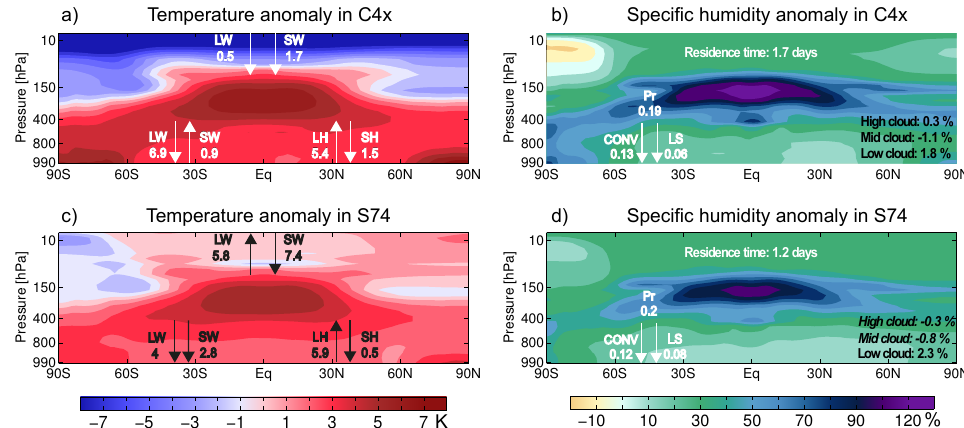
Fig. 4. Profiles of (a) the annual mean anomaly in temperature [K] and (b) the change in specific humidity [%] in the C4x scenario. (c, d) as in (a, b) but for the S74 scenario. The mean anomalies over the five ensemble members averaged over the years 71 to 100 of the corresponding scenario are indicated on the profiles. The energy fluxes are defined as positive in the direction of the corresponding arrow. The units of the energy flux anomalies in (a) and (c) are in Wm − 2 and the units of the precipitation variables in (b) and (d) are in mmday − 1 . Anomalies written in italics indicate that the linear additivity assumption is valid for this variable.